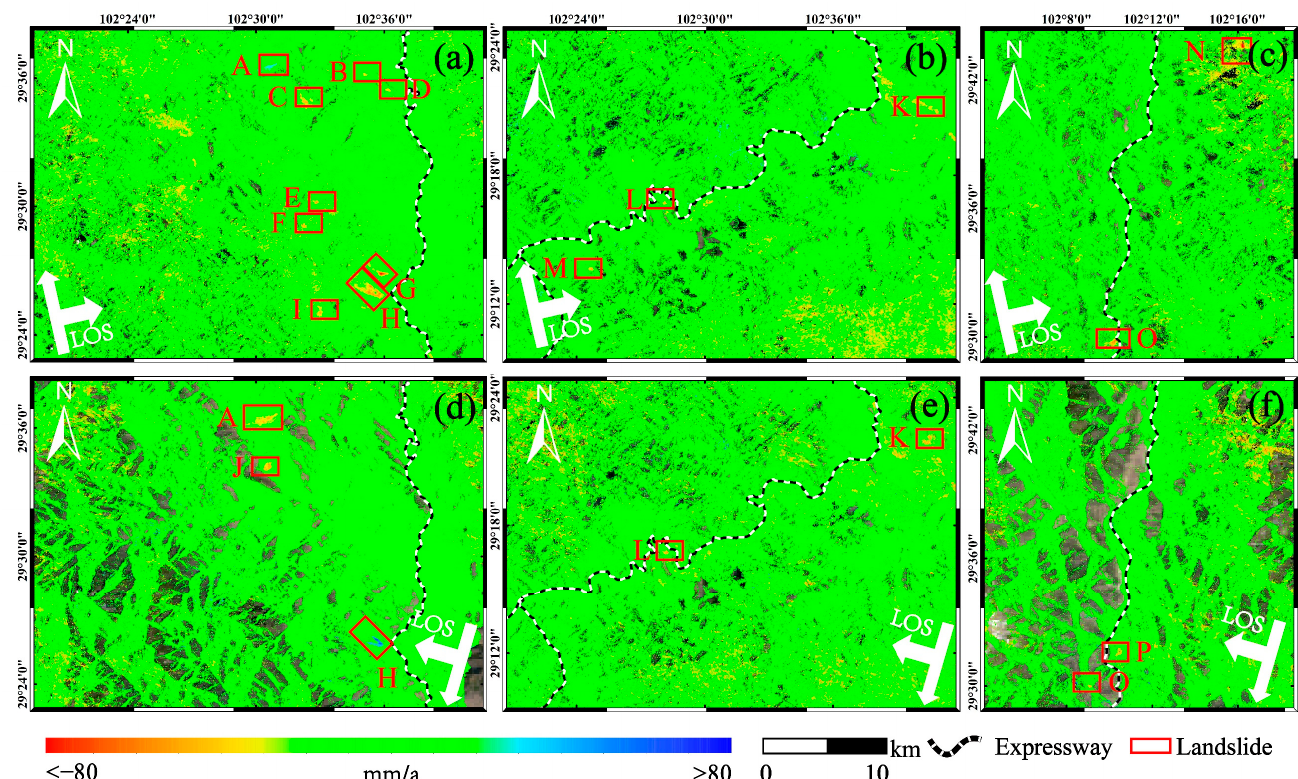
Figure 6. Key areas of landslides: ( a ) and ( d ) represent LOS annual deformation rates in Zone 1 from ascending and descending tracks, respectively; (b) and ( e ) represent LOS annual deformation rates in Zone 2 from ascending and descending tracks, respectively, and ( c ) and ( f ) represent LOS annual deformation rates in Zone 3 from ascending and descending tracks, respectively. Red rectangles indicate a deforming landslide threatening the expressway.